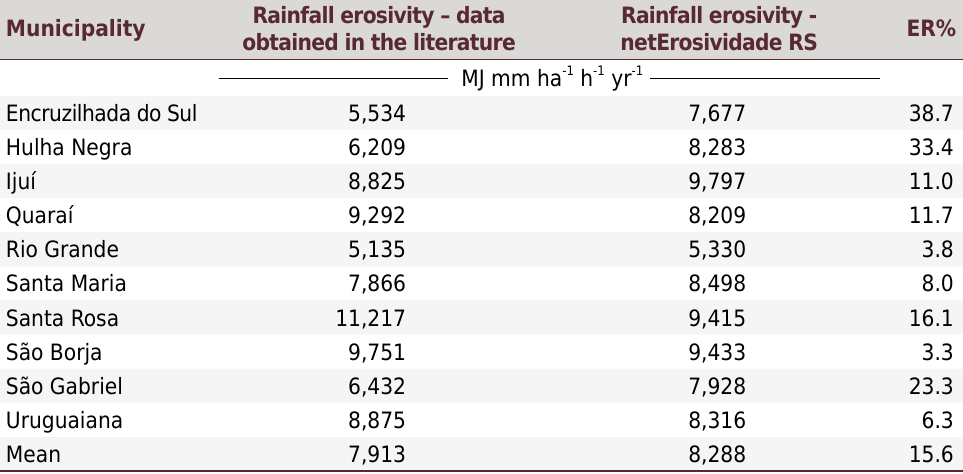
Table 4. Values of rainfall erosivity in municipalities of the state of Rio Grande do Sul, rainfall erosivity values estimated by netErosividade RS and relative error (ER%) Rainfall erosivity – Municipality